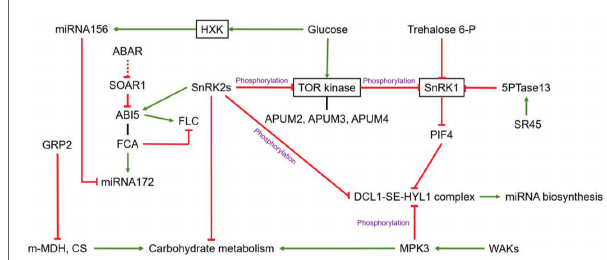
FIGURE 1 | The relationship between sugar and RNA-binding proteins (RBPs), the crosstalk between miRNA and sugar related RNA binding proteins, and alternative splicing in Arabidopsis . The green arrow means stimulation or positive effect, the red line means inhibitory effect, and the black line means protein interaction. GRP2, GLYCINE RICH PROTEIN 2; m-MDH, mitochondrial malate dehydrogenase; CS, citrate synthase; FCA, FLOWERING CONTROL LOCUS A; FLC, FLOWERING LOCUS C; ABI5, ABA-insensitive 5; SOAR1, SUPPRESSOR OF THE ABAR OVEREXPRESSOR 1; DRM2, DORMANCY-ASSOCIATED GENE2; SEN1, SENESCENCE-ASSOCIATED GENE1; ASN1, GLUTAMINE-DEPENDENT ASPARAGINE SYNTHETASE1; 5PTase13, 5-phosphatase 13; SR45, serine/ arginine-rich 45; PIF4, phytochrome-interacting factor 4; MPK3, MITOGEN- ACTIVATED PROTEIN KINASE 3; WAKs, WALL-ASSOCIATED